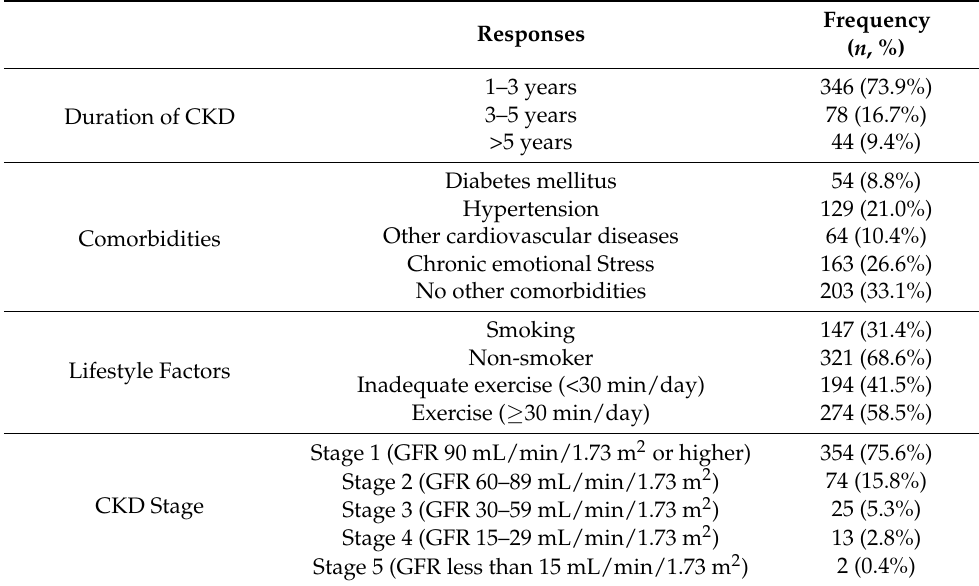
Table 3. Clinical profile and lifestyle factors of the